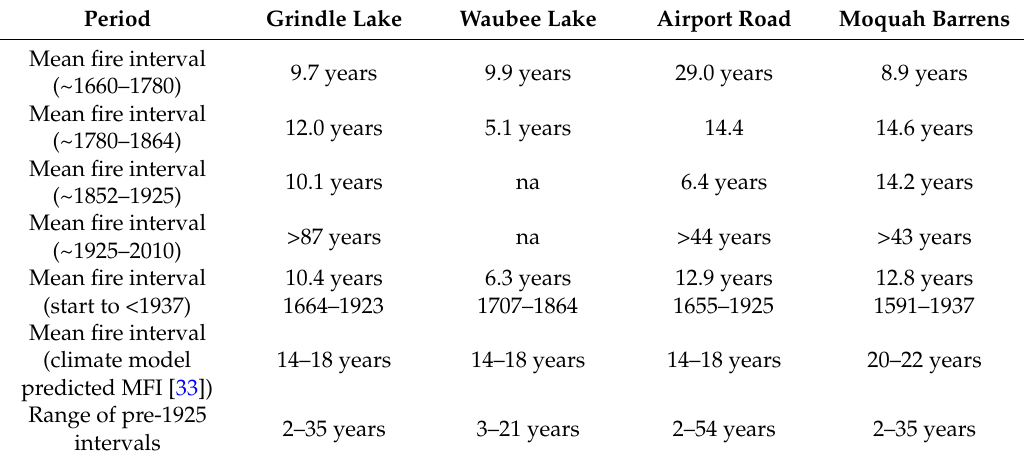
Figure 4. ( a ) Bar plot of the Fire Extent Index (FEI) for Sands Ecological Landscapes of Wisconsin ( n = 98 red pine trees), ( b ) percentage of trees scarred at each of the four study sites through time. Table 2. Fire frequency statistics for study sites. Time periods were selected based on characteristics of fire frequency, human history, and fire history record overlap. Precise time periods vary slightly owing to fire intervals that span the boundaries between time periods. Model predicted MFIs (2nd to last row) are from Guyette et al. 2012. Periods not covered by the fire scar record are represented by “na”.